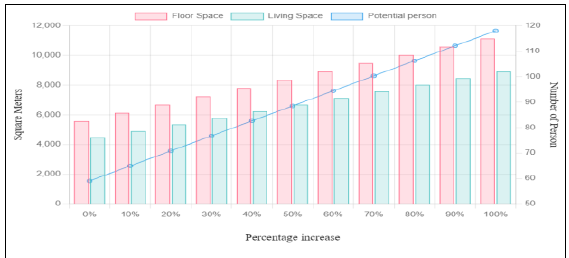
Figure 12 : Chart Showing the Potential of the Land in Terms of Floor Space (m²), Living Space (m²) and Number of Residents.